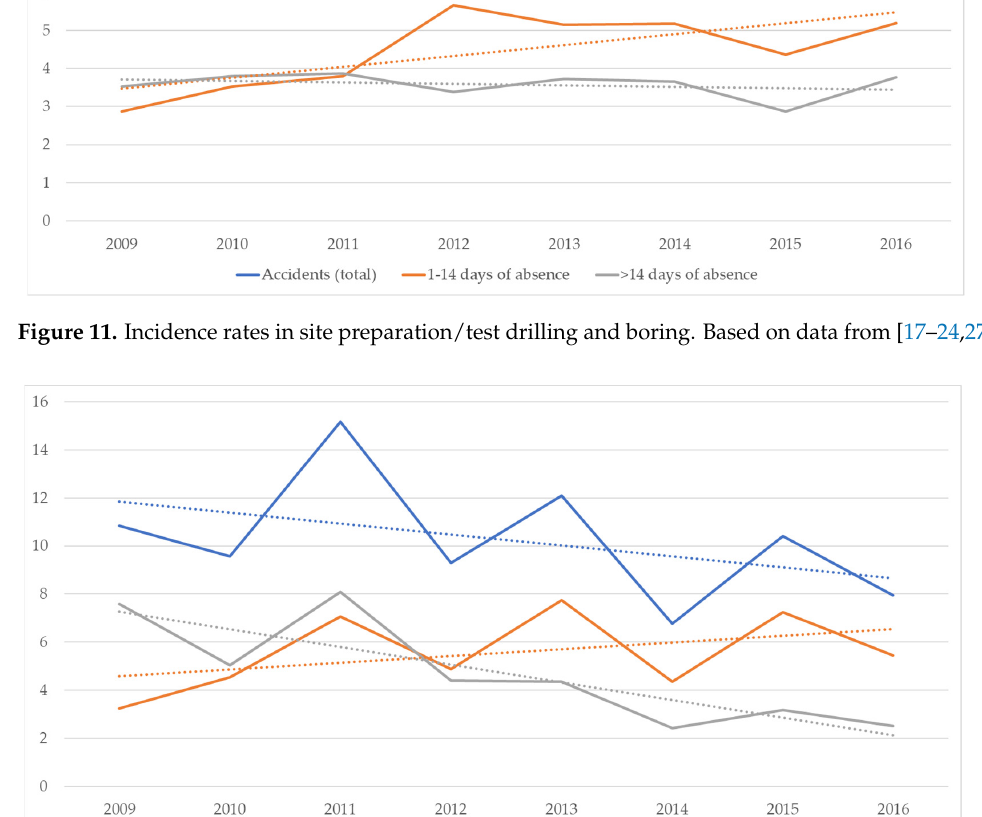
Figure 12. Incidence rates in plastering. Based on data from [17 – 24 , 27] .